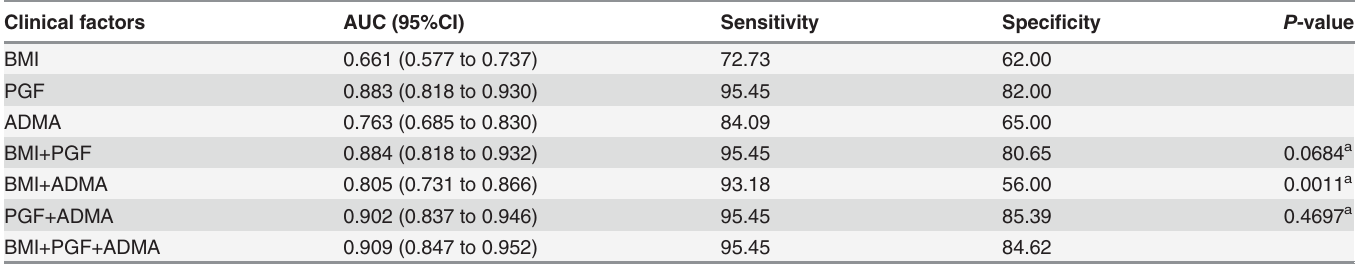
Table 3. Areas under the curve, sensitivity and specificity of first trimester PGF, ADMA, BMI and for prediction of preeclampsia. Clinical